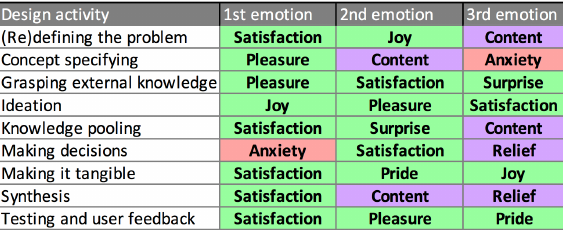
Table 3. All of the 20 emotions listed next to the design